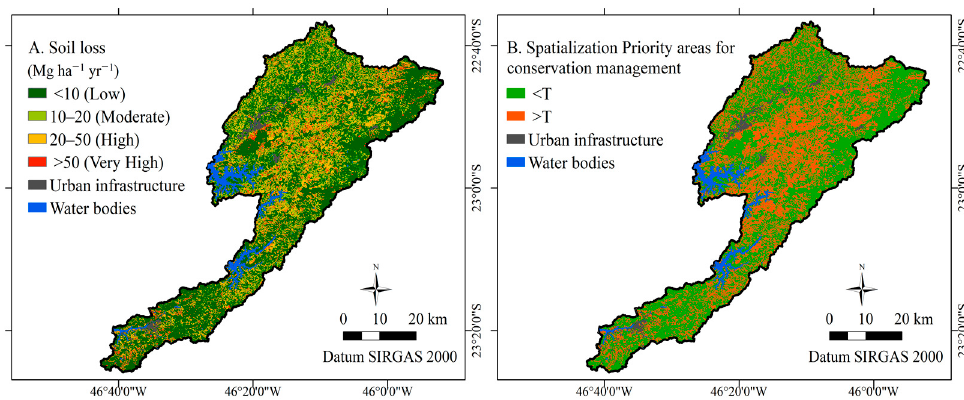
Figure 5. Map of the spatial distribution of soil loss rates ( A ) and priority areas for conservation management ( B ) in the Cantareira System, São Paulo, Brazil. The geographic coordinate system is UTM Sirgas 2000. The basemap is available on ArcMap v. 10.5.